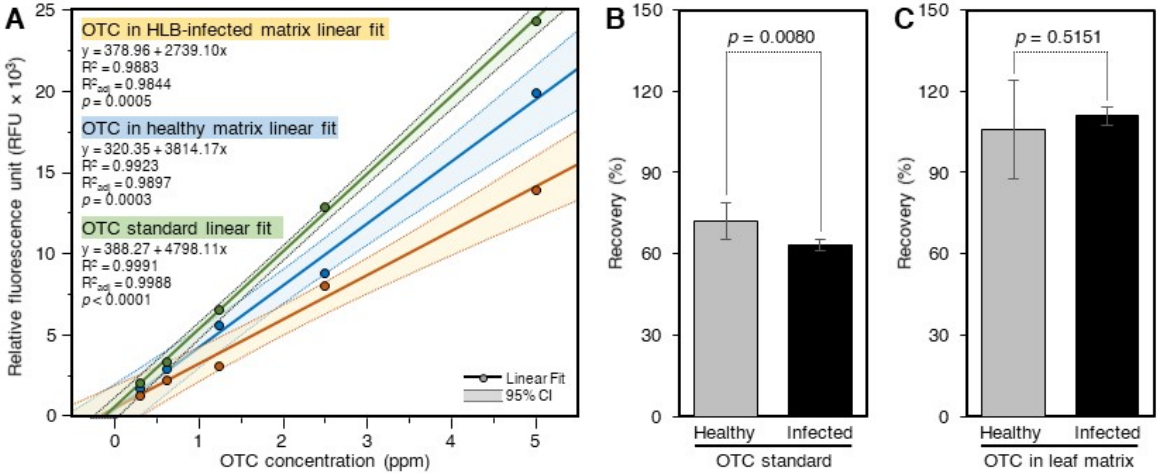
Figure 1. Recovery of OTC from spiked citrus leaves. ( A ) Standard curves of OTC in 60% methanol and citrus leaf extract of healthy and ‘ Ca. L. asiaticus’-infected plants. The standard curves were prepared in the sample matrix by spiking the leaf extracts with OTC and then passing them through SPE. ( B ) Recovery of OTC from spiked ‘ Ca. L. asiaticus’-infected and healthy leaves as calculated using the pure standard. ( C ) Recovery of OTC from spiked ‘ Ca. L. asiaticus’-infected and healthy leaves as calculated using the standards prepared in the sample matrices and cleaned by SPE. Data are the means ± SD of five replicates ( n = 5). Values with p -values < 0.05 are significantly different using a two-tailed student t -test.